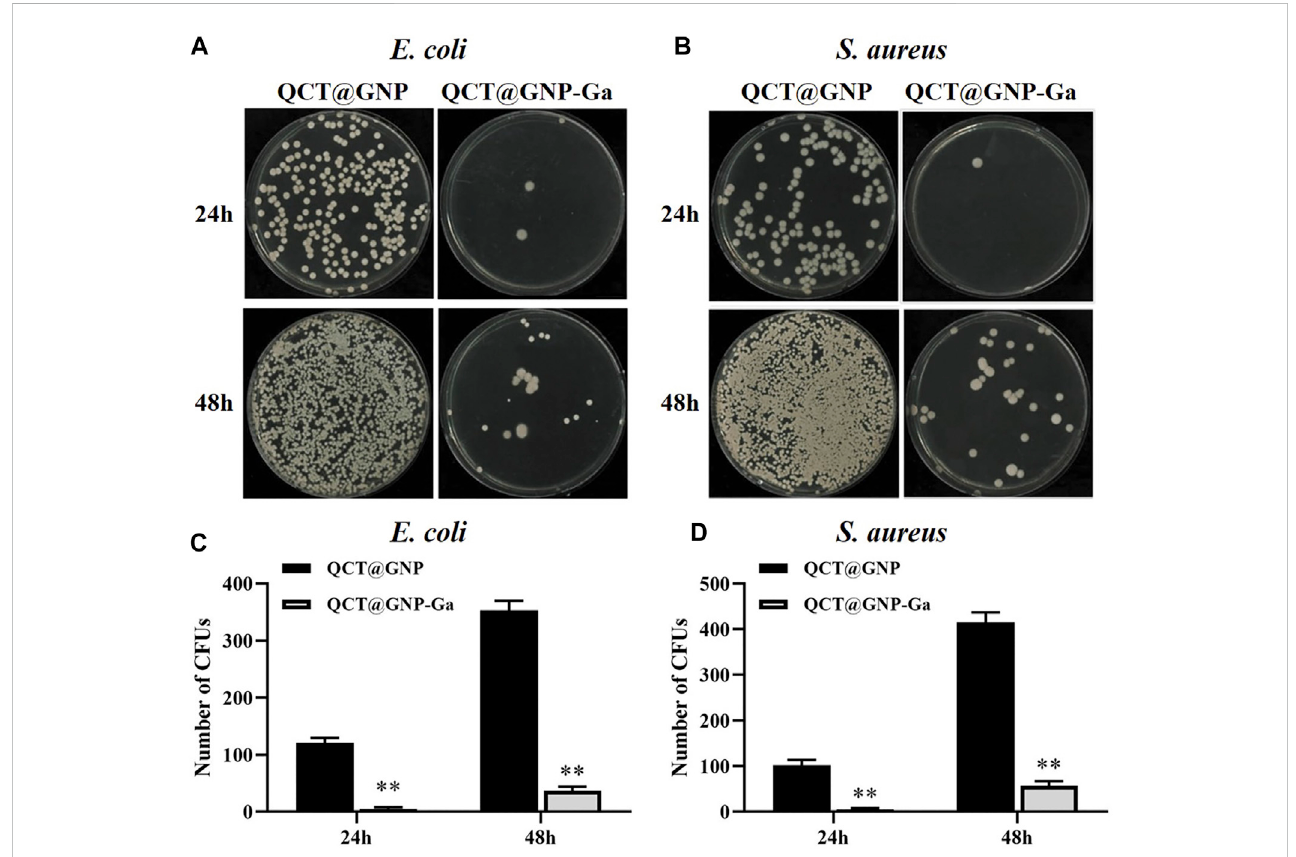
FIGURE 3 Anti-bacterialactivityofQCT@GNP-Ga. (A,B) Imagesand (C,D) statisticalresultsofcolonyformingunit(CFU)of E.coli and S.aureus treatedwithQCT@ GNP or QCT@GNP-Ga. Data are shown as mean ± SD, * p < 0.05 compared with QCT@GNP